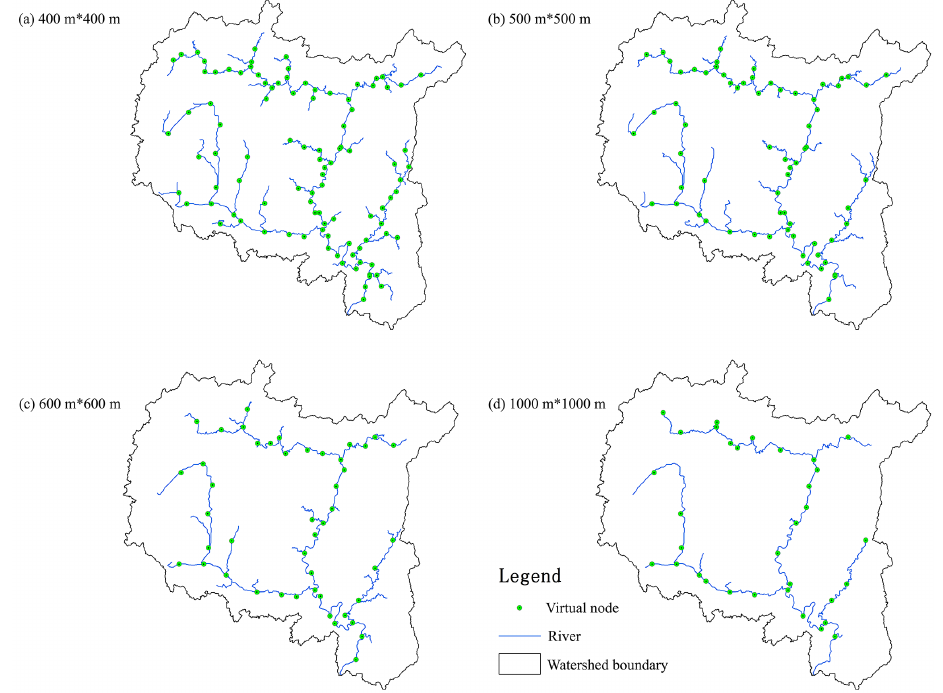
Figure 6. Liuxihe model structure setup for LRB with different